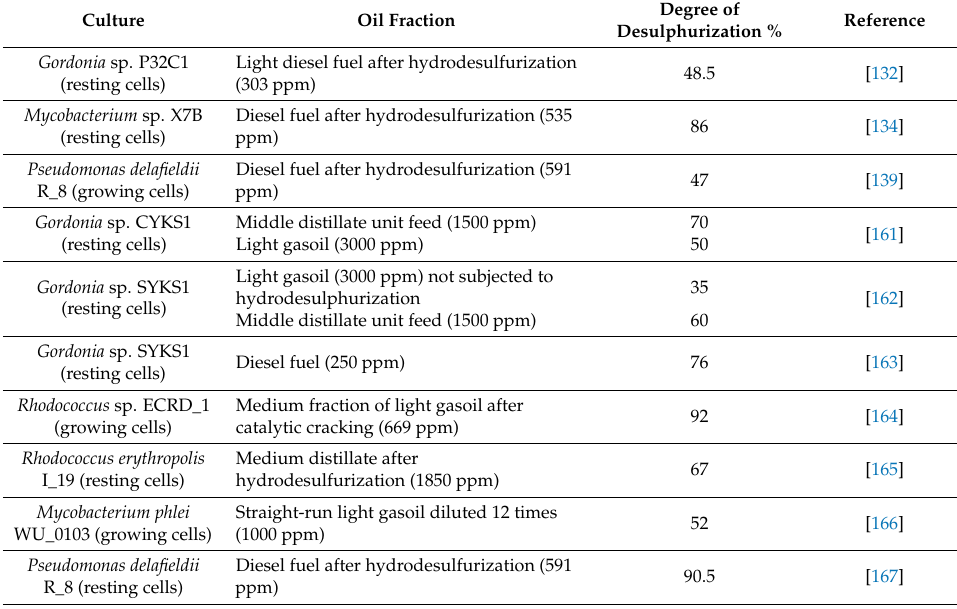
Comparative characteristics of the efficiency of selected aerobic cultures in real fuel